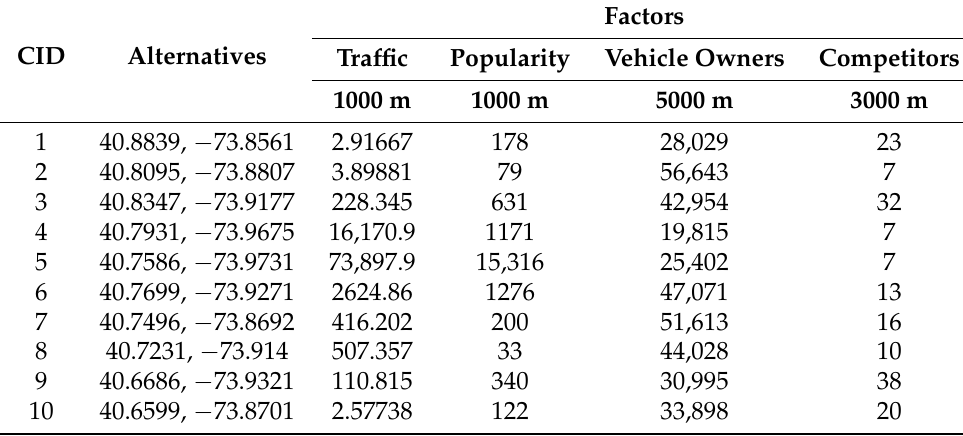
Table 2. Candidate sites factor computation.